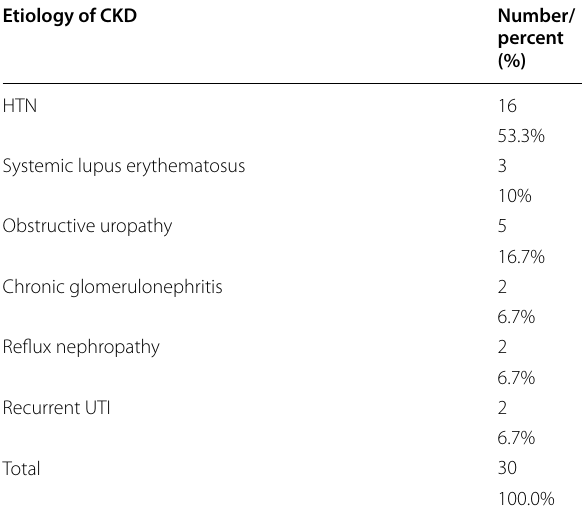
Table 2 Etiology of CKD in the study population